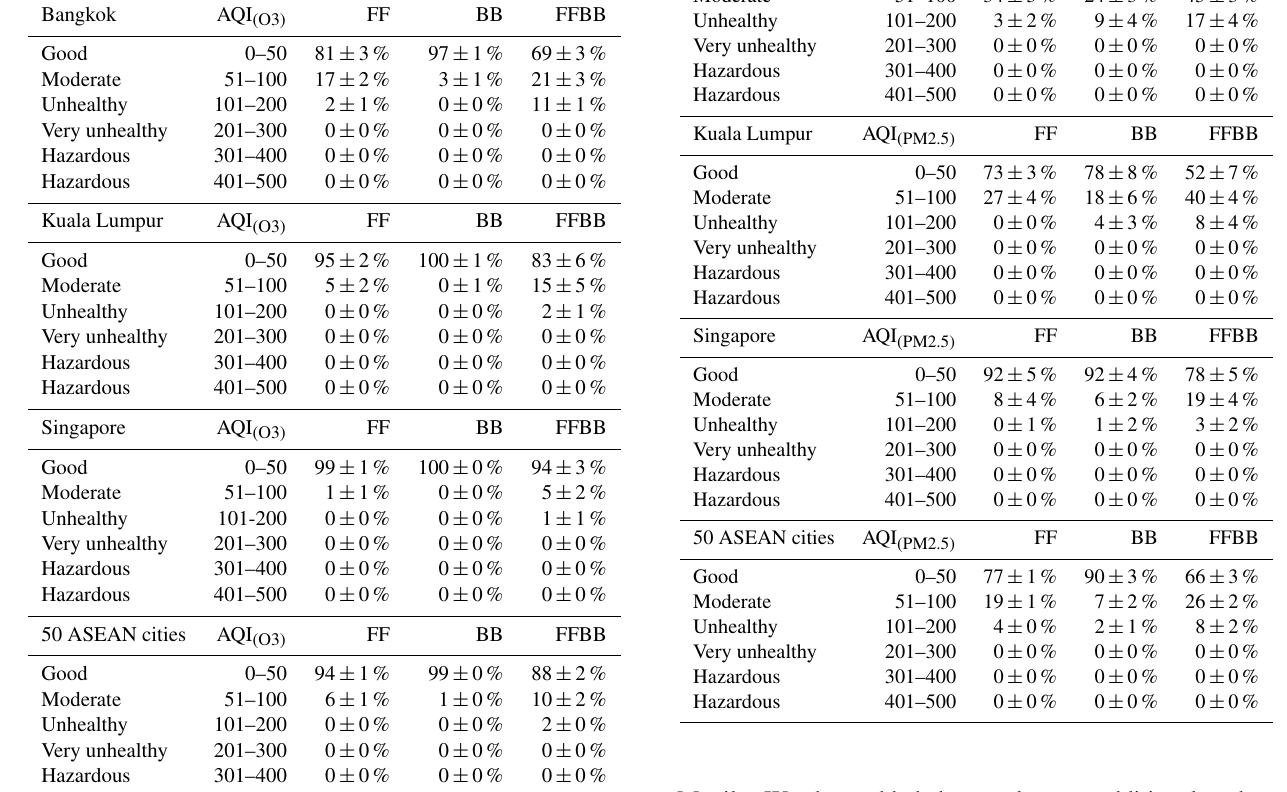
Table 3. The frequency of air pollution levels in Bangkok, Kuala Lumpur, Singapore, and 50 Association of Southeast Asian Nations (ASEAN) cities derived using 9h ozone (O 3 ) volume mixing ratio in FF, BB, and FFBB during 2002–2008.